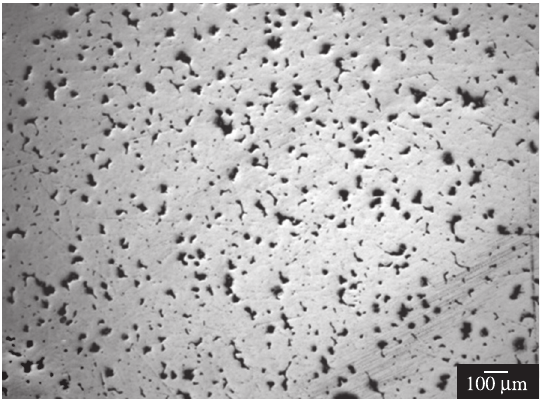
Figure 13. Phase diagram of Ti – O 18